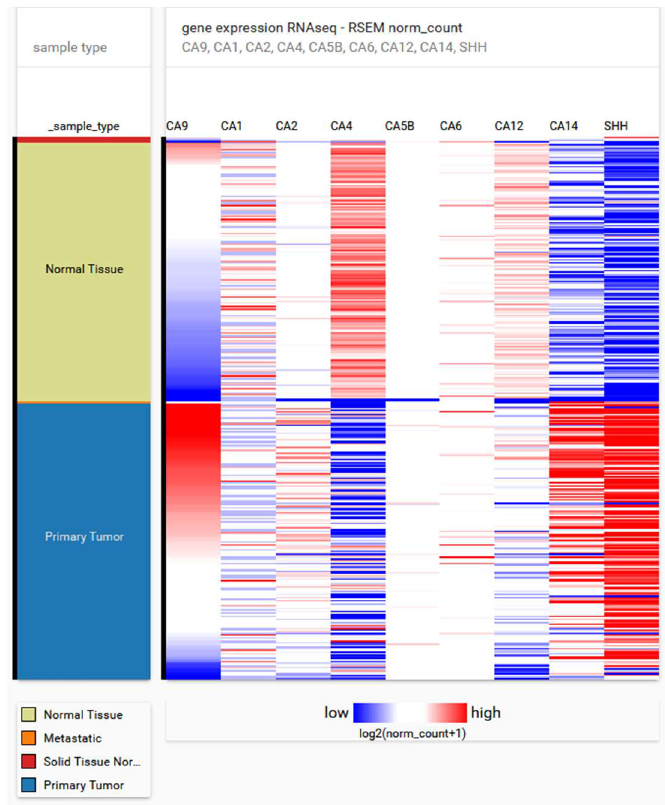
Figure 1. The expression profile of selected carbonic anhydrase isoforms and sonic hedgehog (activated in pancreatic cancer) in 179 samples of pancreatic adenocarcinoma and 171 normal pancreatic tissue samples extracted from Xena (using the cancer genome atlas (TCGA) target GTEx datasets) [15] (for more information see Supplementary Material). Expression of CA9 increases in pancreatic ductal adenocarcinoma samples along with Sonic Hedgehog (SHH) level. Analysis of CA9 promoter revealed possible regulation through Sonic Hedgehog (SHH) pathway (see Figure 2). According to the carbonic anhydrase nomenclature, human CA isoenzymes are written in capital Roman letters and numerals, while their genes are written in Italic letters and Arabic numerals.